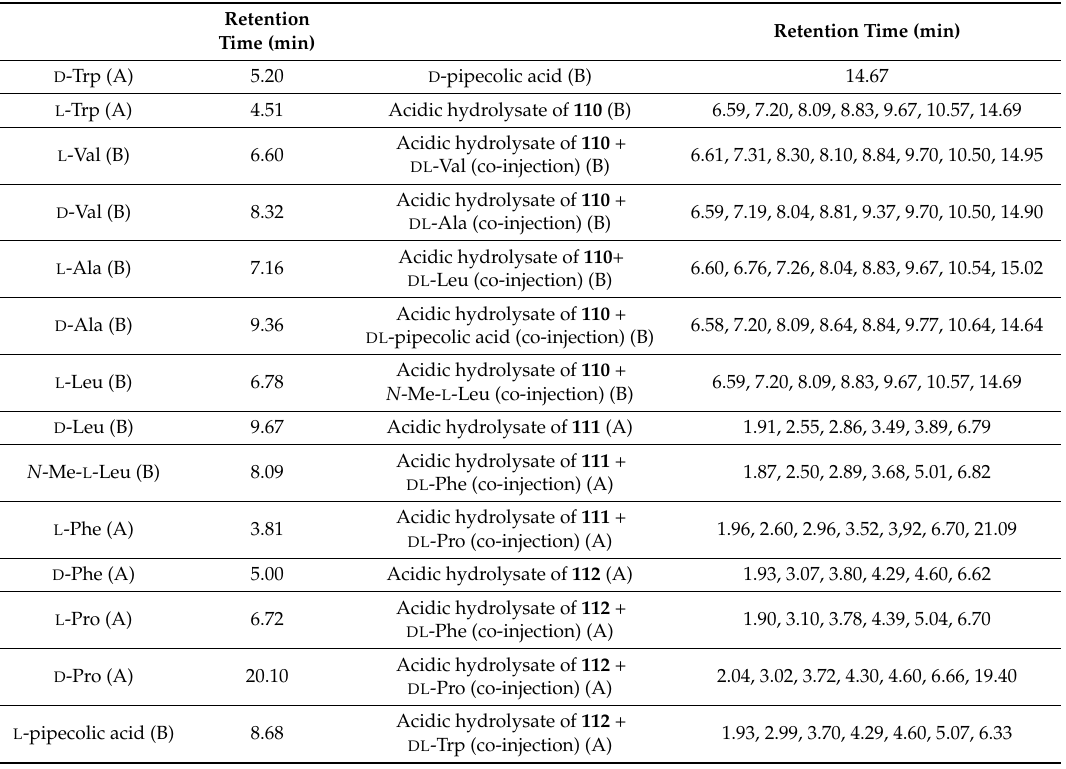
Figure 19. Chromatograms of enantiomeric mixture of DL -Ala ( a ), L -Ala ( b ), and D -Ala ( c ). Column, Chirobiotic T; Mobile phase, MeOH:H 2 O:acetic acid (70:30:0.02 v / v / v ); Flow rate, 1.0 mL/min; UV detection, 210 nm. Table 12. Chiral HPLC analysis of the acidic hydrolysates of 110 , 111 and 112 by co-injection with amino acids standards.